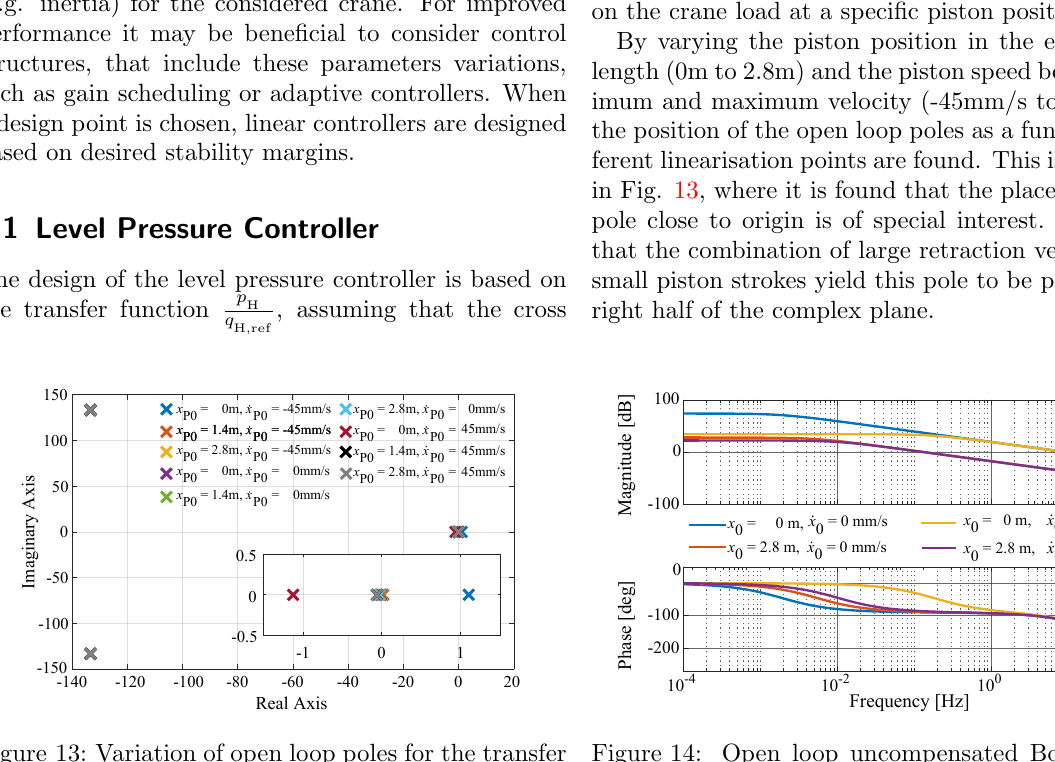
Figure 13: Variation of open loop poles for the transfer function p H . q H,ref